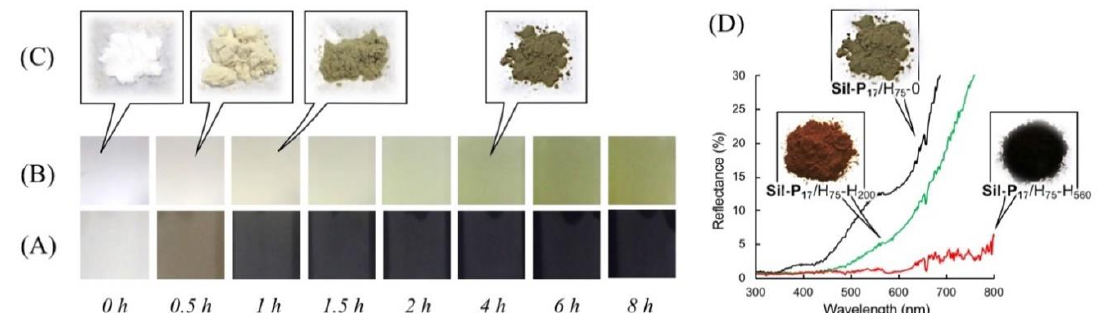
Figure 4. Monitoring of the color change during the polymer lamination process. The polymerization was carried out using 1 g of Sil-0 , 120 mg of DHN, and 97 mg of TMTA in ethanol at 75 °C. ( A ) and ( B ) show the color difference of the sample suspensions without dilution and with dilution to 1/10, respectively. ( C ) shows the color difference of the corrected solid. ( D ) shows the reflection spectra of the corrected solid.